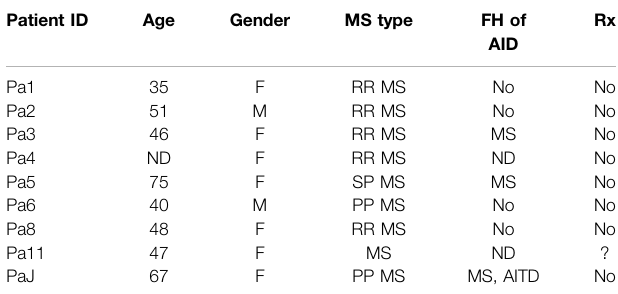
TABLE 2 | Characteristics of multiple sclerosis (MS) patients and controls. North American Cohort of MS patients. ND : Non-disclosed, FH: Family History; AID: Autoimmune Disease; AITD : autoimmune thyroid